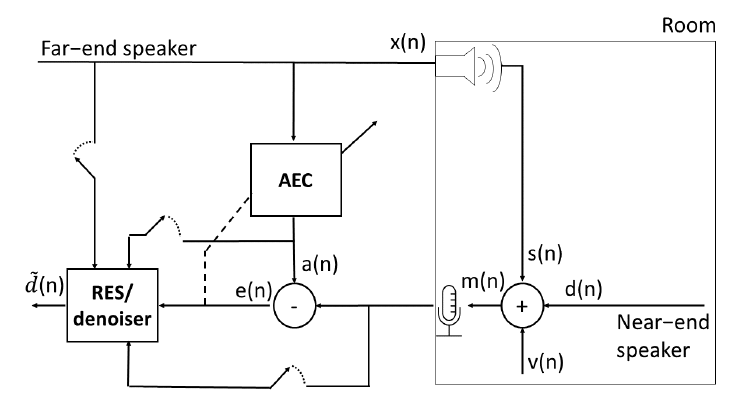
Figure 1. Residual echo suppression